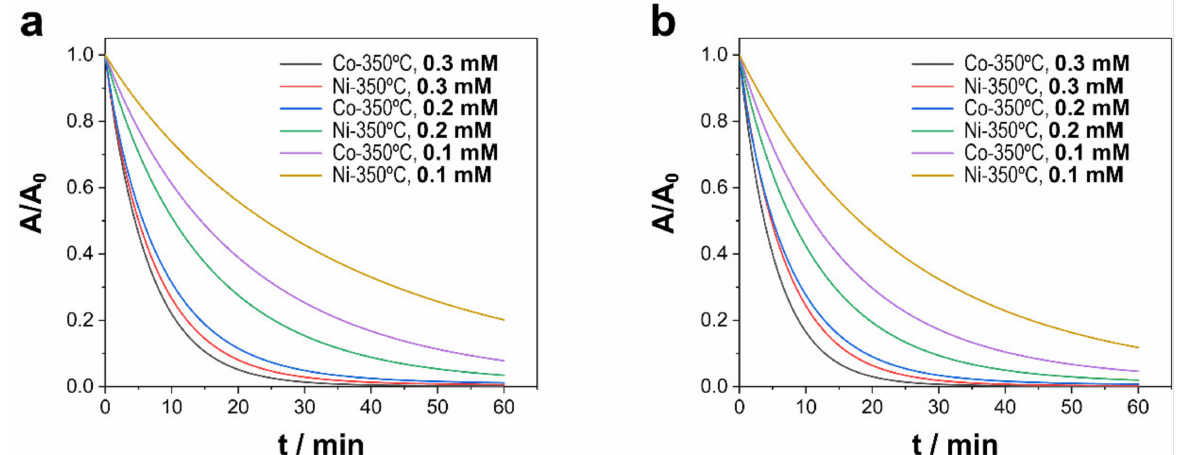
Figure 5. Catalytic degradation of TCs as a function of the concentration of PMS using different Ni–CoNi and Co–CoNi deposits annealed at 350 ◦ C at ( a ) a pH of 6.0 and ( b ) a pH of 8.0. Experimental